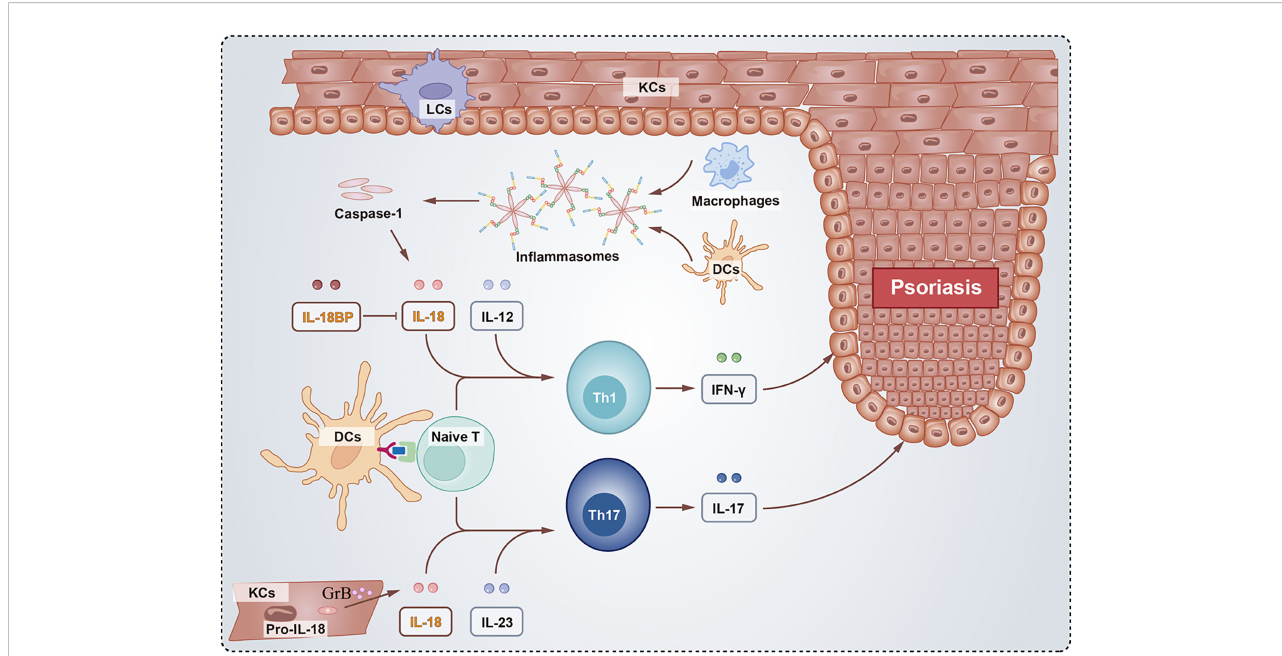
FIGURE 3 Schematic of the role of IL-18 and IL-18BP in psoriasis. The activated in fl ammasomes directly recruit and cleave procaspase-1 into caspase-1, whose proteolysis activate the pro-in fl ammatory cytokine IL-18. Besides, proIL-18 were cleaved by GrB in KCs. In fl ammatory cytokines including IL-12 and IL-23 produced by Naïve T together with IL-18 facilitate the differentiation of Th1 and Th17 cells, respectively. The Th1 cells secrete IFN- g and Th17 cells secrete IL-17 both contributing to psoriasis. However, IL-18BP binds to IL-18 blocking the development of